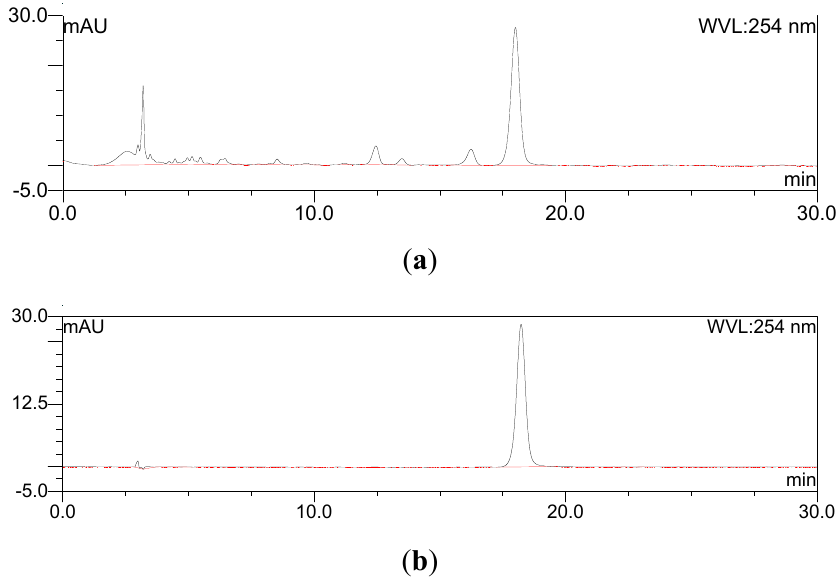
Figure 8. Thin-layer chromatography (TLC) after development at ( a ) visible light, ( b ) 254 nm, ( c ) 366 nm, and ( d ) after spraying with 10% methanolic KOH reagent (A = rhein sample before purification, B = rhein sample after purification, C = rhein standard, and D = residue from the CHCl 3 layer).